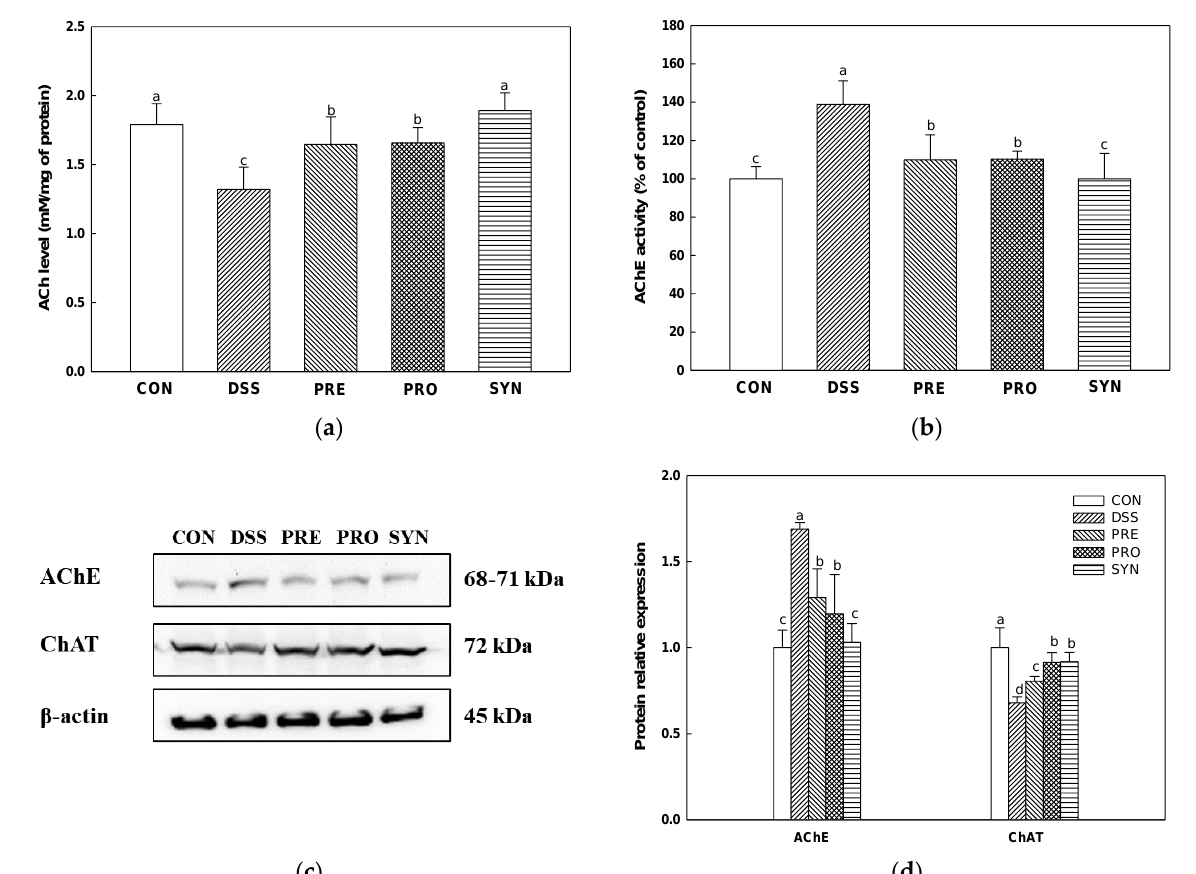
Figure 7. Effects of PRE, PRO, and SYN on cognitive impairment of DSS-induced colitis mice via regulation of cholinergic system. Acetylcholine (ACh) content ( a ), acetylcholinesterase (AChE) activity ( b ), Western blot band images ( c ), and the expression levels of AChE and choline acetyltransferase (ChAT) ( d ). The results were presented as the mean ± SD (ACh content and AChE activity, n = 5; Western blot, n = 3). Data were statistically considered at p < 0.05, and different lowercase letters